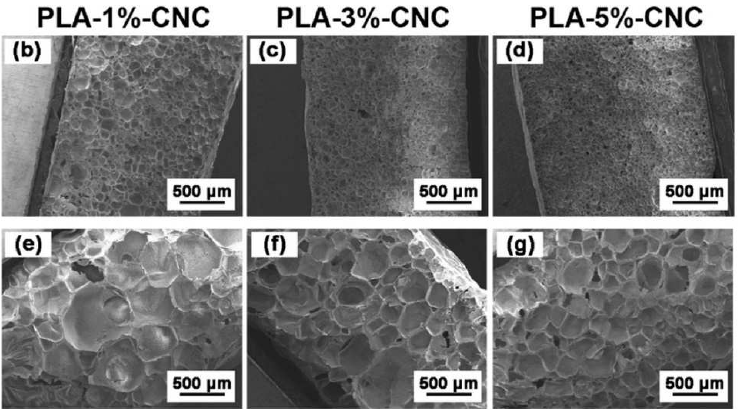
Figure 8. SEM images of cross-sectioned PLA/CNC composite foams with different CNC content (up to 5 wt%): ( b – d ) prepared by the Pickering emulsion masterbatch route; ( e – g ) prepared by direct melt blending (reproduced with permission from Reference [69], Copyright 2021 American Chemical Society).